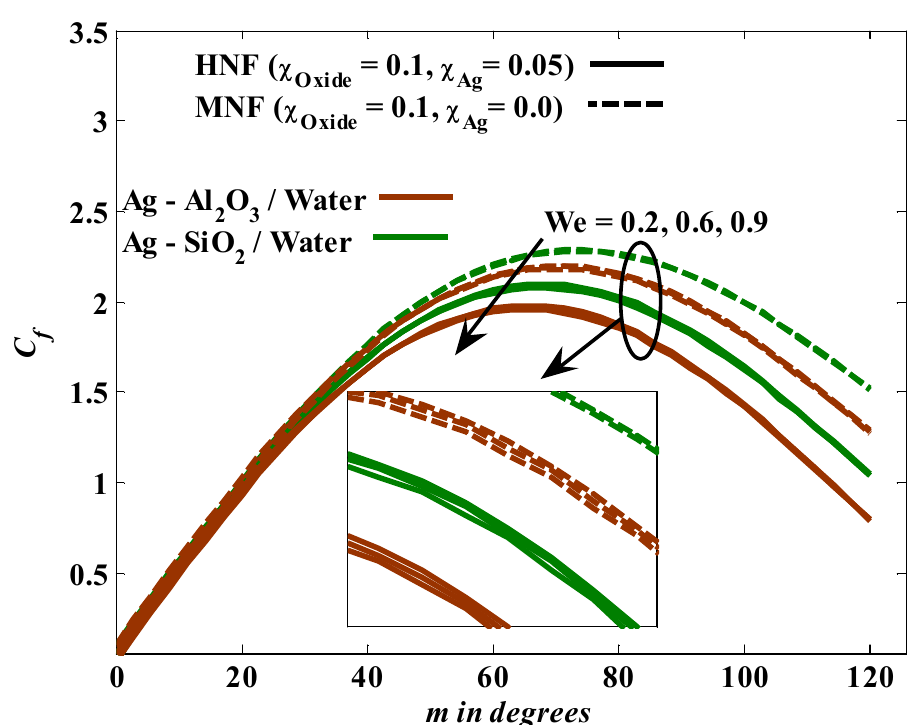
Figure 3. Illustration of We versus skin friction at fixed values of λ = 0.2, R = 0.1, & M = 1.